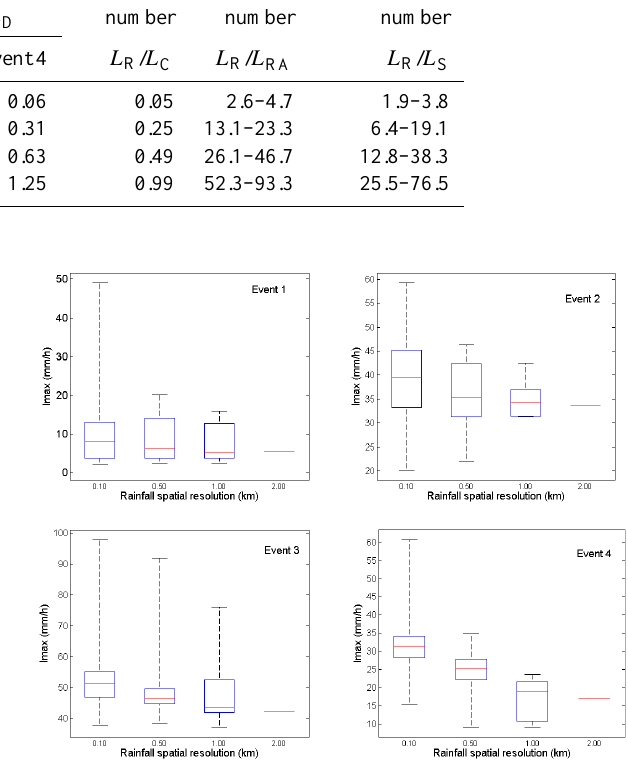
Figure 6. Normalised rainfall volumes versus catchment sampling number ( L R / L C ) : mean and standard deviation of normalised rain- fall volumes computed over the catchment, for the four events.